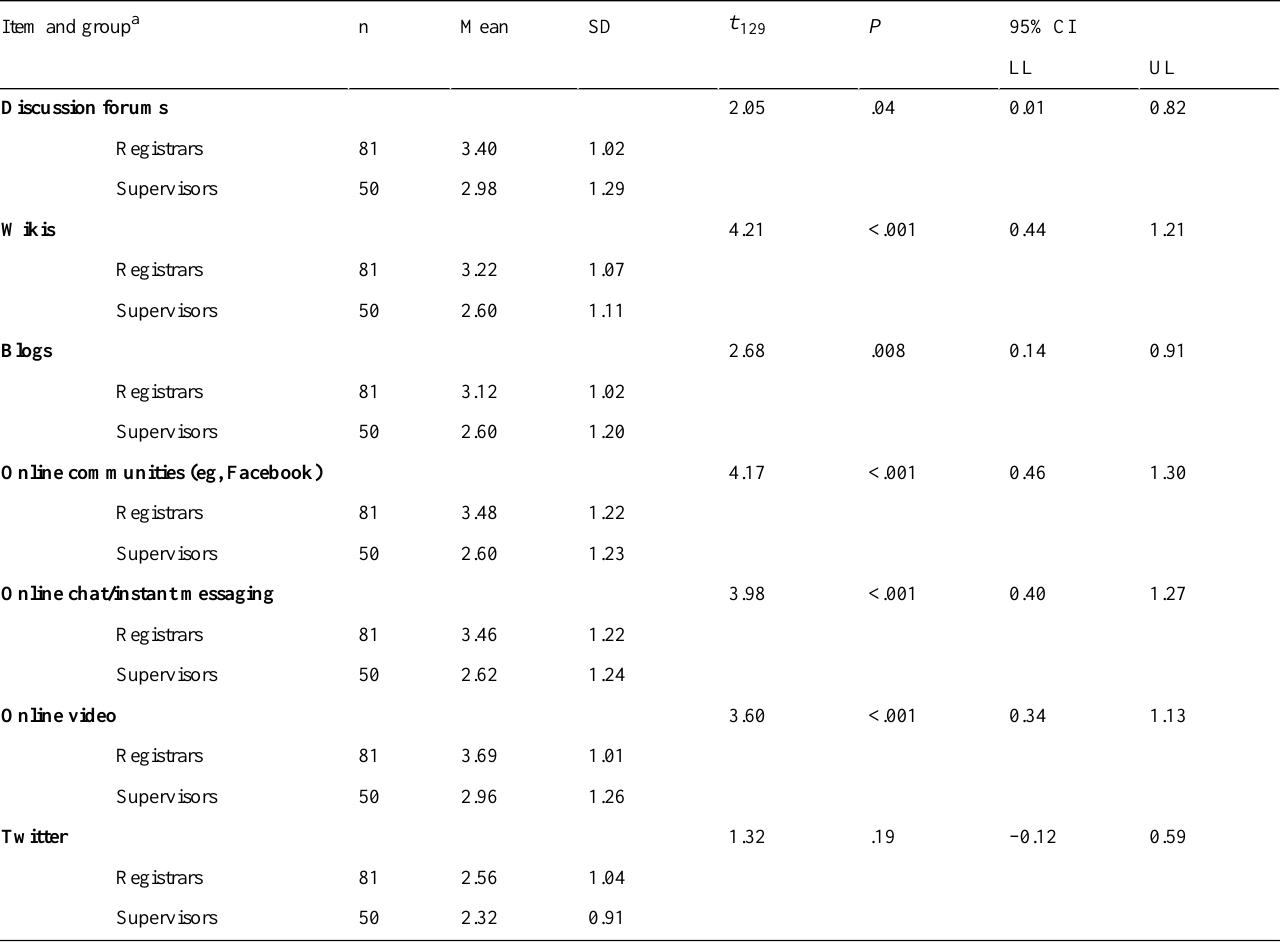
Table 2. Means and standard deviations for confidence using Internet-based applications and